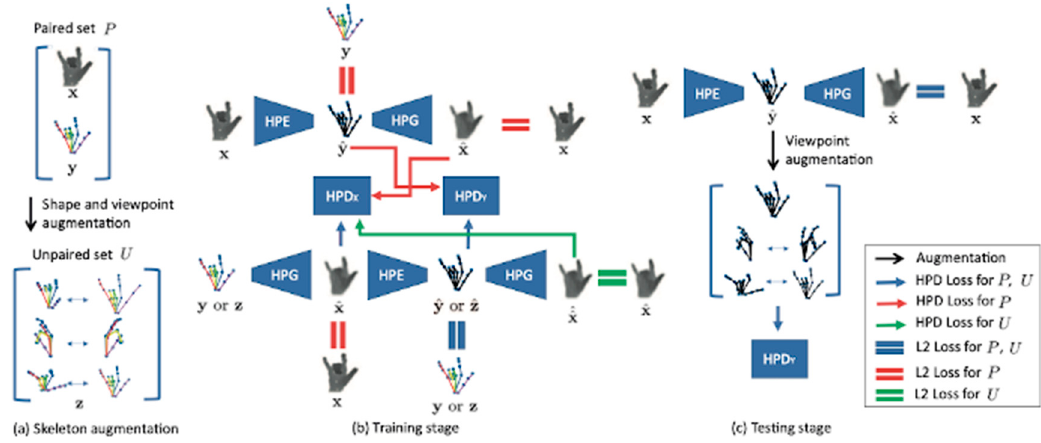
Figure 11. The augmented skeleton space model [83]. HPE: hand pose estimator; HPG: hand pose generator; HPD: hand pose discriminator.